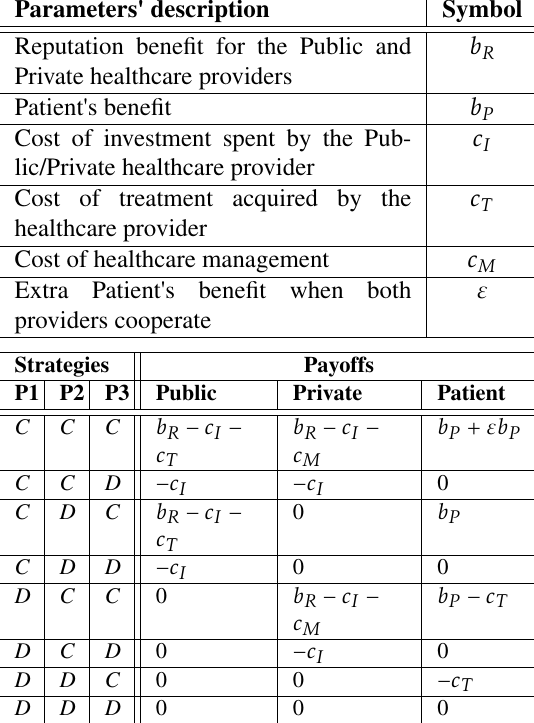
Table 1. The healthcare model (Public: P1 , Private: P2 , Patient: P3